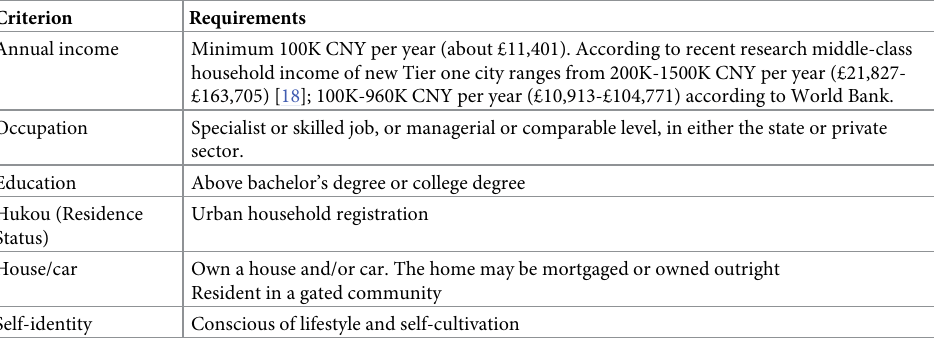
Table 1. Selection criteria for participants.